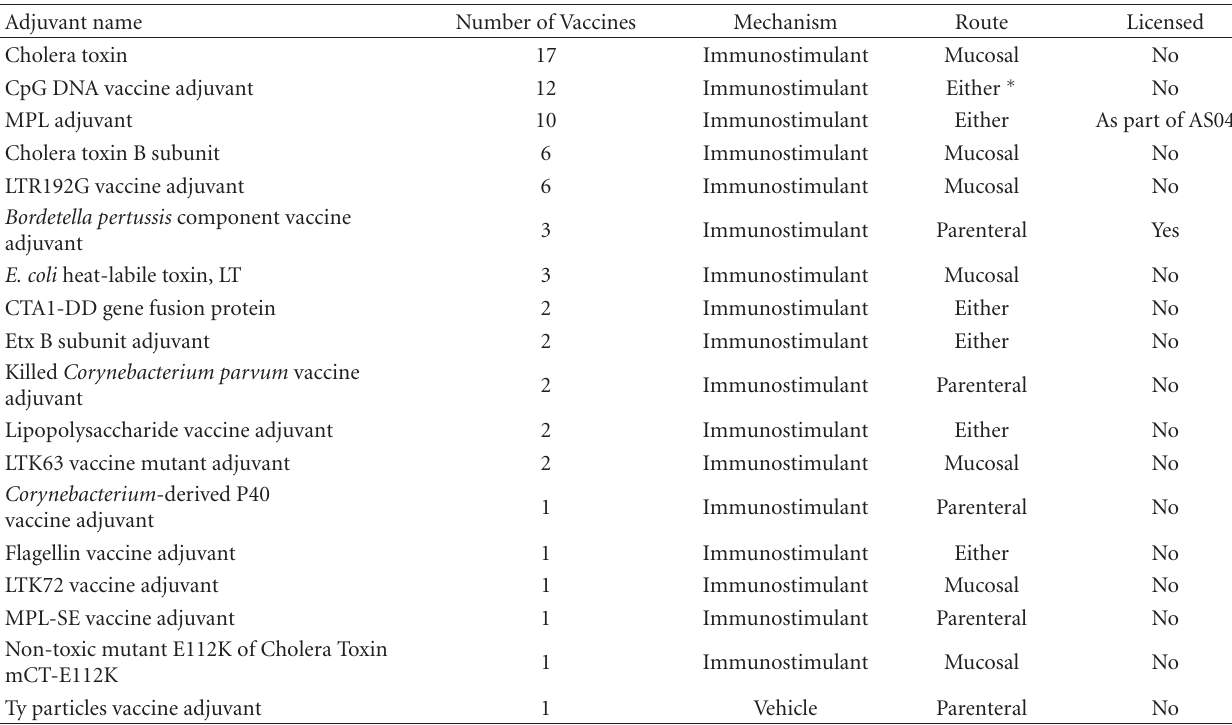
Table 4: Microorganism-derived